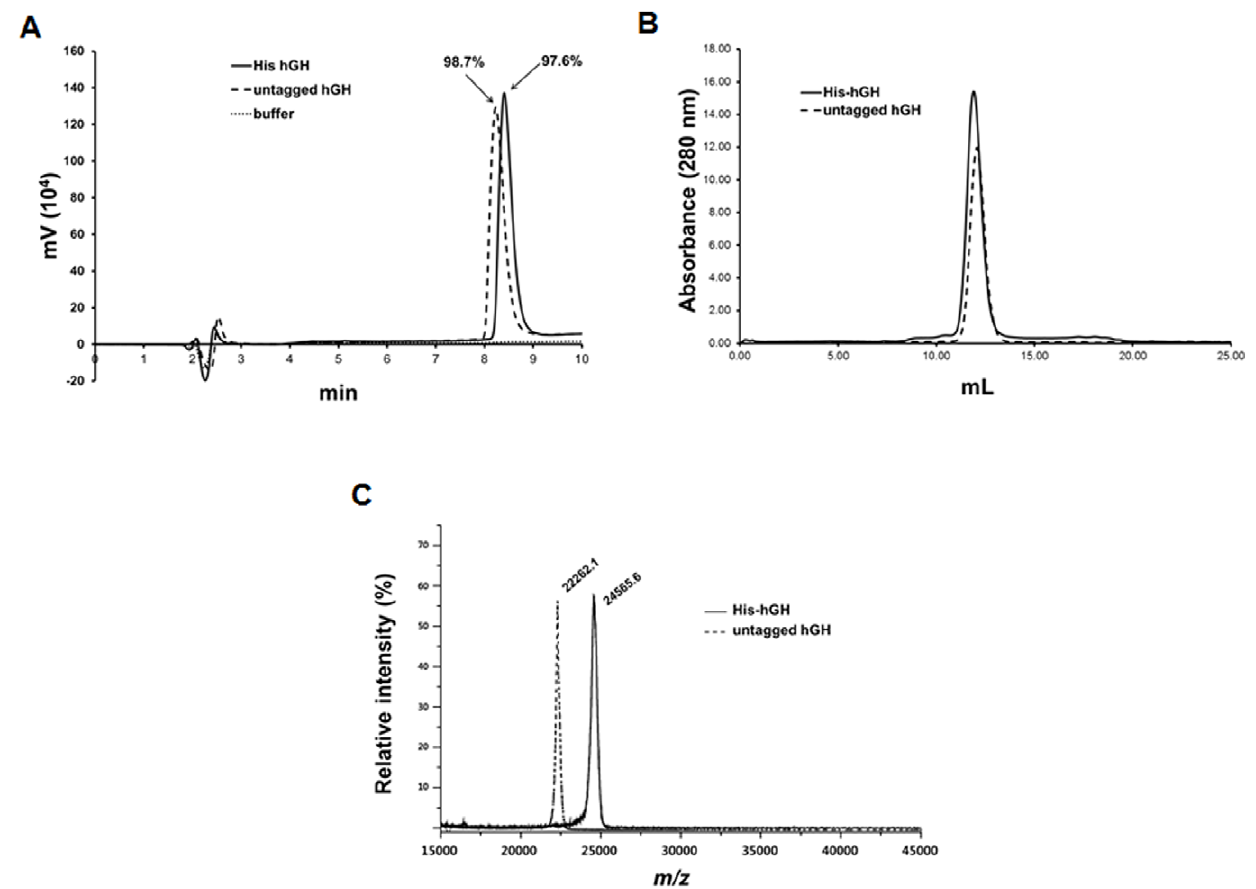
Figure 4. Characterization of purified hGH. (A) RP-HPLC chromatograms of purified hGH. Separation was performed by isocratic elution using trifluoroacetic acid-water-acetonitrile. Vertical axis units represent mV detector output. (B) Analytical size exclusion chromatography (SEC) of purified hGH. (C) MALDI-TOF mass spectrometry analysis of purified intact hGH. Spectra were acquired over the m/z range 15000–45000 Da in the positive ion mode.